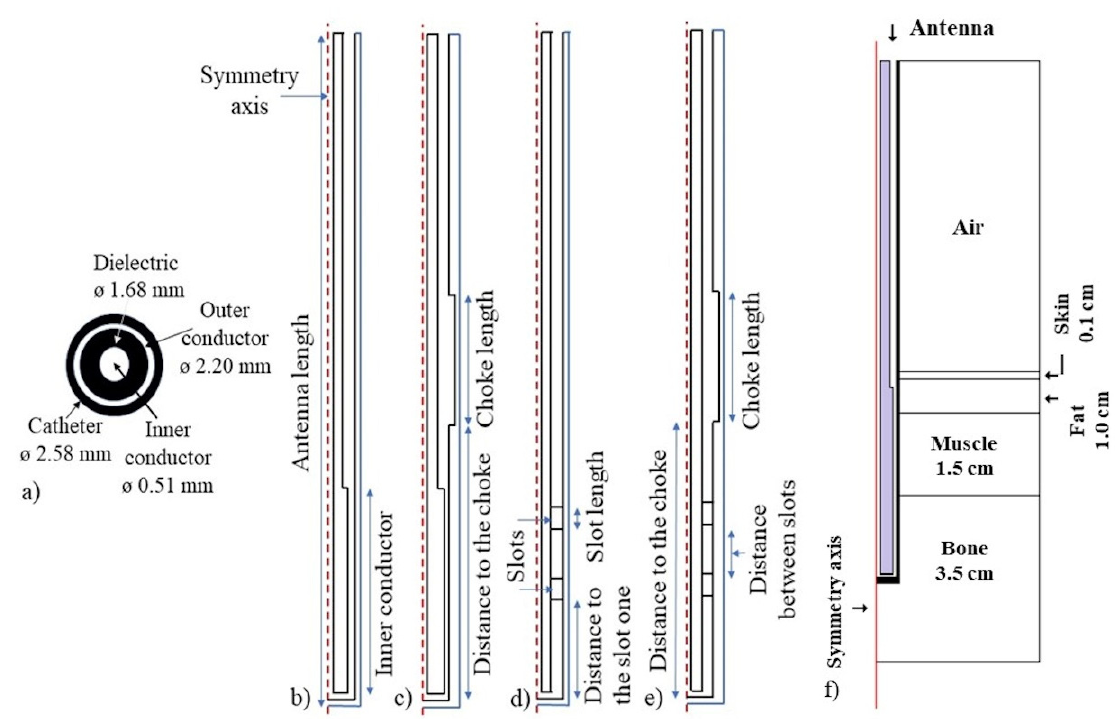
Figure 1. Axi-symmetric geometry of the micro-coaxial antennas. ( a ) micro—coaxial cable transversal view and its diameters. ( b ) Metal—tip monopole (MTM) antenna, ( c ) Choked metal—tip monopole (CMTM) antenna, ( d ) Double slot (DS) antenna and ( e ) choked double slot (CDS) antenna, ( f ) Antenna inserted in a multilayer tissue model to evaluate its per- formance.